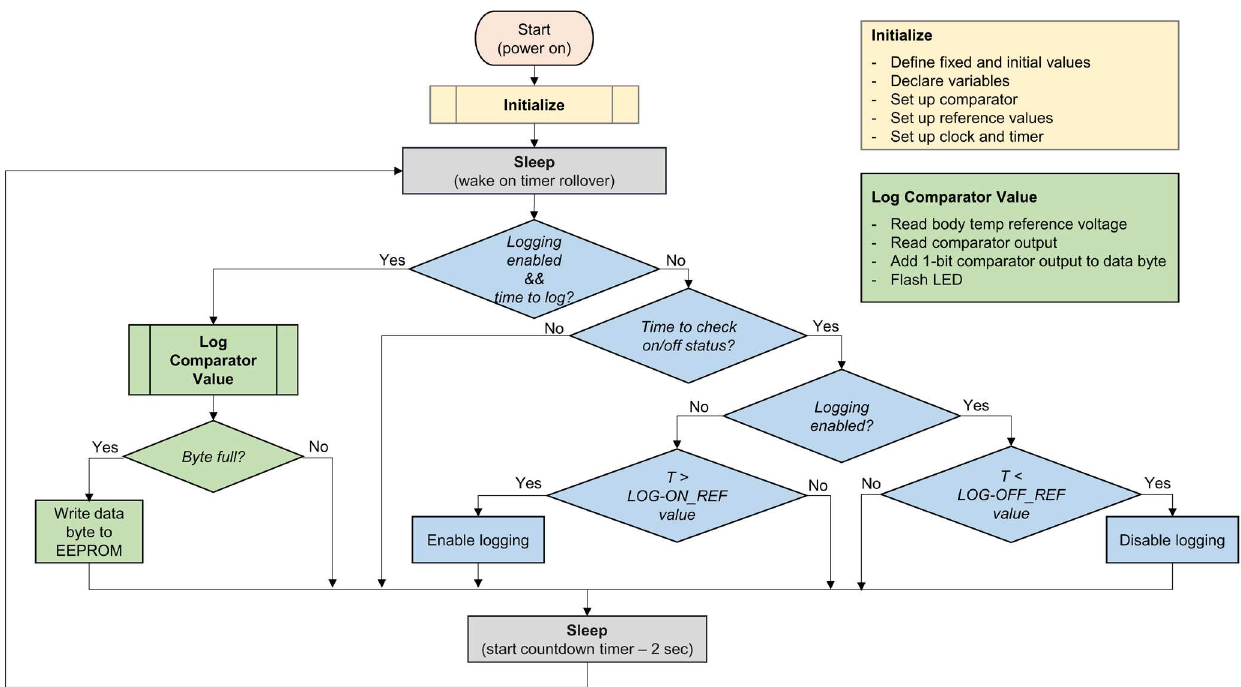
Fig 3. Flow diagram for adherence IVR embedded code. Major device programfunctions are indicatedby color with arrows showingprogram executionflow: device initialization(orange),sleep state (gray), loggingstatus control and timing (blue), and data loggingand storage (green)